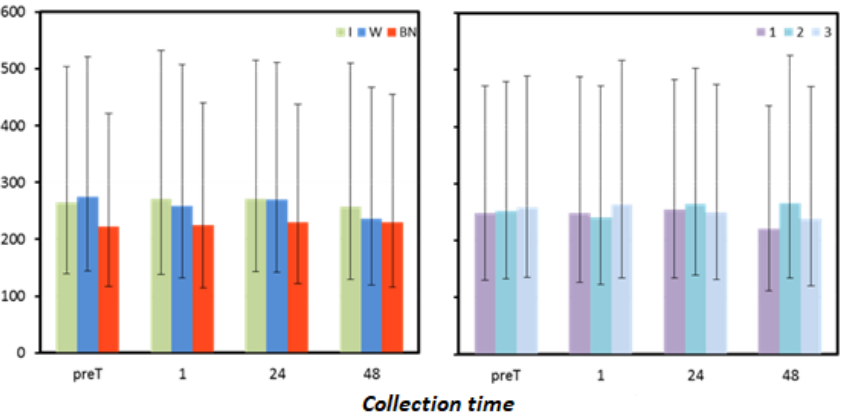
Figure 6. Lactate dehydrogenase mean values estimated via the least squares method with upper and lower confidence intervals for four measurements[U.mL −1 ]. Table 10. Results of analysis of variance for lactate dehydrogenase measured before the test (preT) and 1, 24, and 48 h after the exercise test: significance of (P) and F-statistic along with the number of degrees of freedom (DFi — in the numerator; DFm — in the denominator) for the fixed effects (hydra- tion strategy, test sequence, and their interaction).